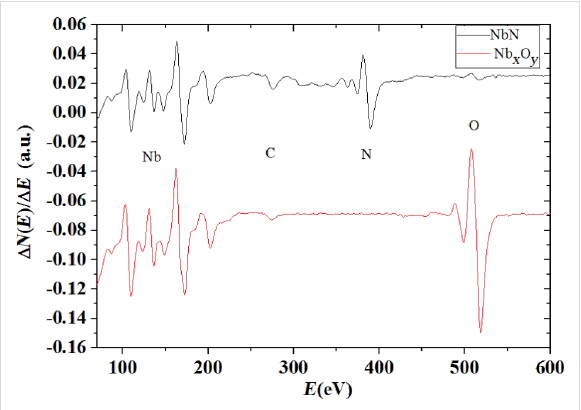
Figure 9 for the symbols): T INT /( T EXT + T INT ) ≈ 0.0846/0.194 and T OX ≈ 1.8· T EXT .